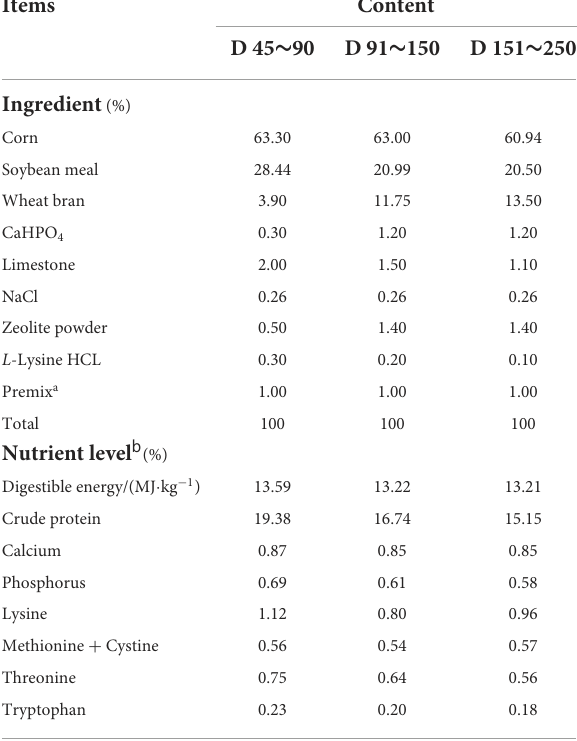
TABLE 1 Composition and nutrient levels of basal